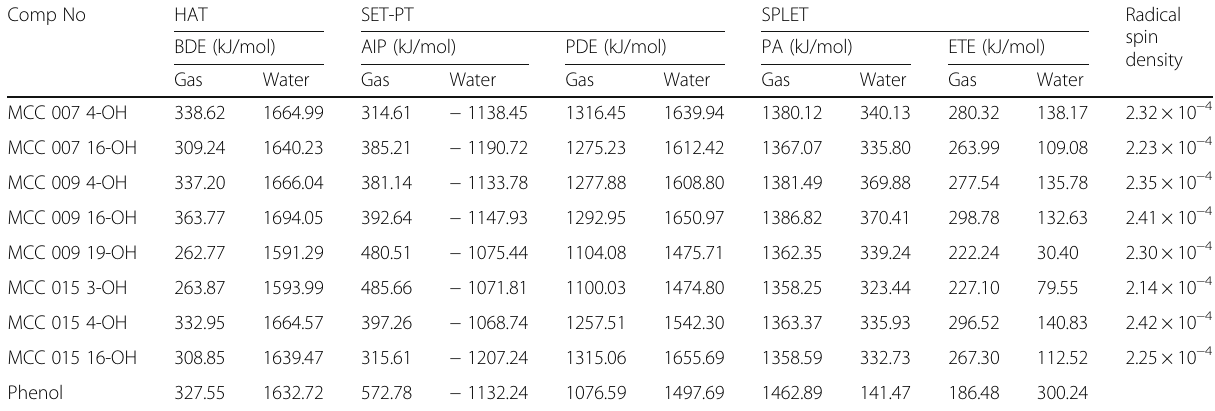
Table 2 Antioxidant properties of designed curcumin derivatives calculated at the B3LYP/6-311G*/6-31G* level in vacuum and water.